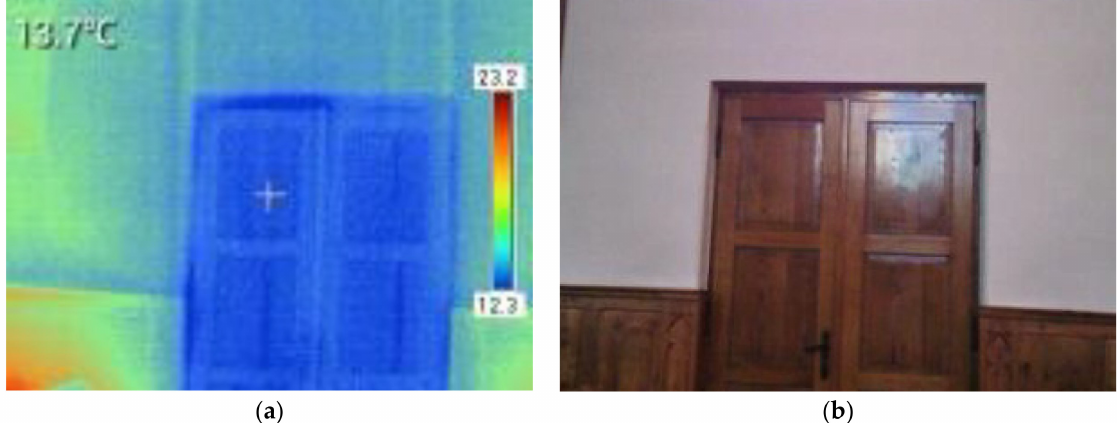
Figure 6. ( a ) Photos from the KT-165 thermal imaging camera with the side door of the church, ( b ) RGB image with the same side door of the church.